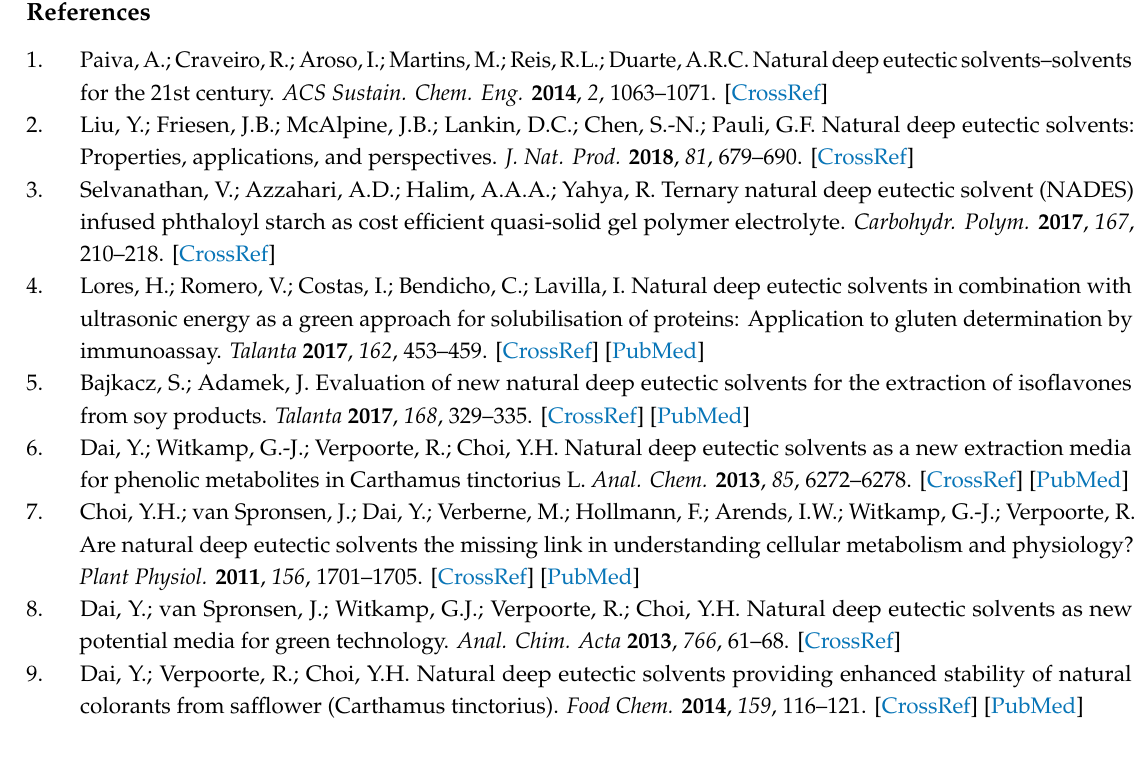
Supplementary Materials: The following are available online, Figure S1: Solubility of quercetin in ChCl-Xyl with di ff erent water content at 25 ◦ C. The solubility of quercetin measured in weight fraction, Wq of quercetin., Figure S2: Molecular structural formula of xanthan gum ( a ), choline chloride( b ) and xylitol ( c